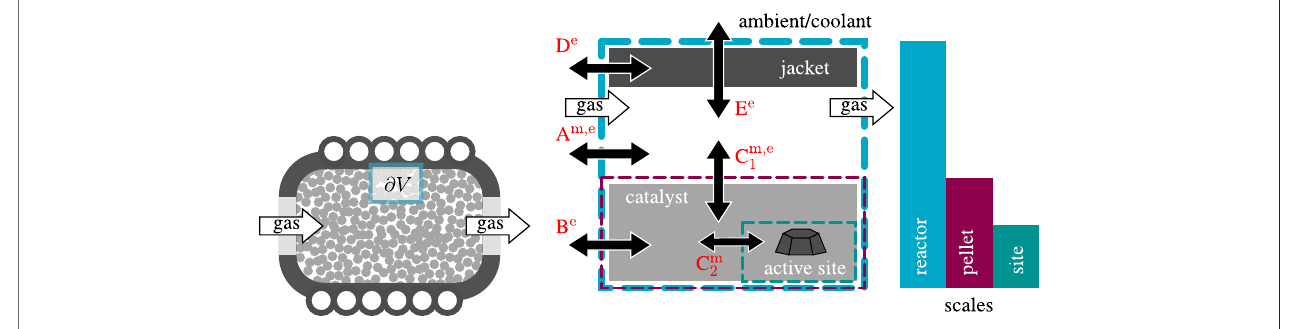
FIGURE3| FluxnetworkandsourcesAtoEforintrinsicmultiplicitywithin fi xed-bedreactors,doublearrowsindicatemass(m)and/orenergy(e) fl uxestobepartof the respective source.